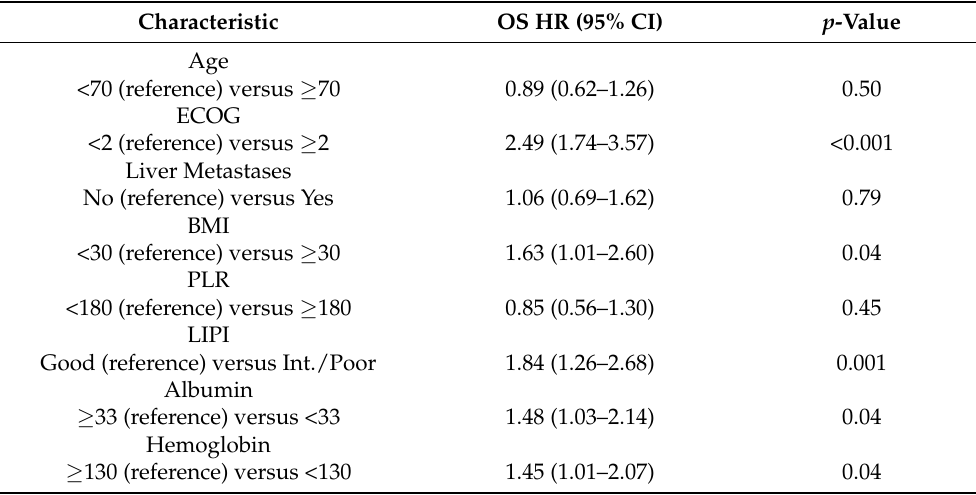
Table 4. Multivariate analysis of the clinical and laboratory factors associated with